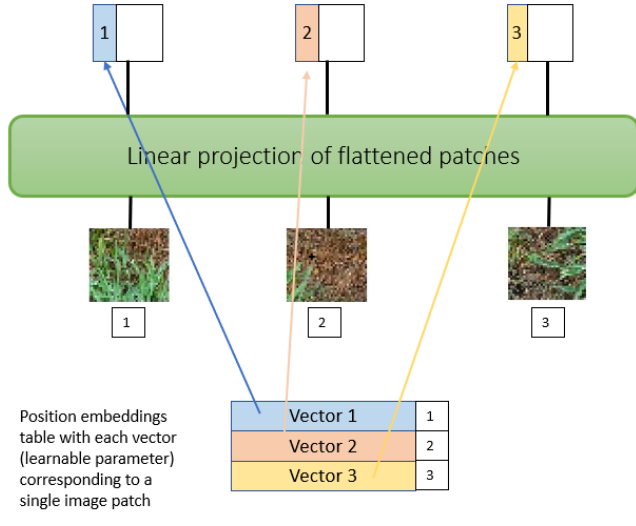
Figure 8. Positional embeddings as vector